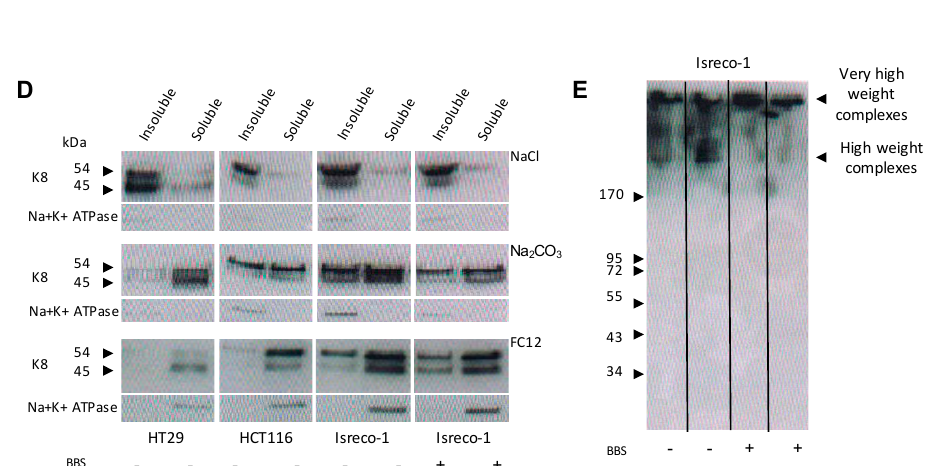
Figure 4. eK8 is a strongly anchored plasma membrane protein. ( A ) Isopycnic centrifugation on sucrose gradient of Isreco-1 cell lysates. Western blot (WB) analysis using the M20 antibody showing that K8 is present in the 20%, 30%, and 40% sucrose fractions and distributed across the cytoplasm, endoplasmic reticulum (ER) membrane, and plasma membrane. ( B ) The separation of cellular components of Isreco-1 cells in order to determine the precise accumulation of K8 in organelle membranes (ER and Golgi), plasma membrane, and cytoplasmic compartments by WB analysis (M20 antibody). ( C ) Plasma membrane enrichment of Isreco-1, HCT116, and HT29 colorectal cancer (CRC) cell lines and WB analysis of K8 accumulation using M20. ( D ) Solubilization of plasma membrane proteins of Isreco-1 (treated or not with bombesin (BBS)), HCT116, and HT29 cells in NaCl, sodium carbonate (Na 2 CO 3 ), or FC12 detergent, and WB analysis of K8 accumulation using M20. ( E ) Plasma membrane protein solubilization in the presence or absence of 2 mM ethylenediaminetetraacetic acid (EDTA). The separation of plasma membrane proteins of Isreco-1 cells treated or not with BBS was then conducted on non-denaturing native gels, followed by WB analysis of K8 accumulation using M20.